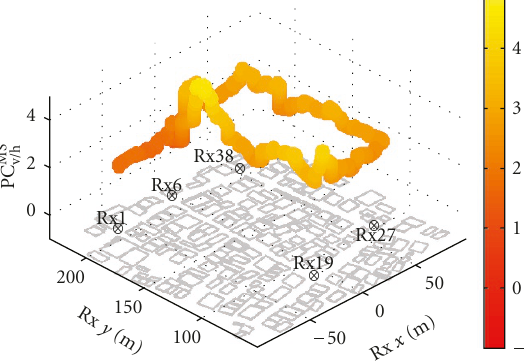
of the DMCs Δ s = 20 (ca 3m). v